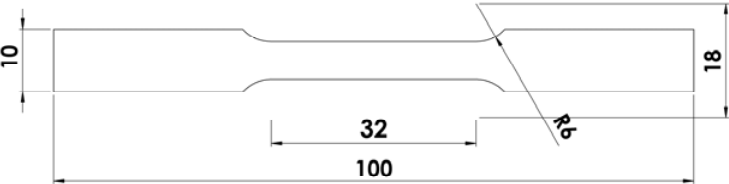
Figure 2. Schematic illustration of the specimen subjected to mechanical properties tests according to ASTM B 108 ‐ 1.